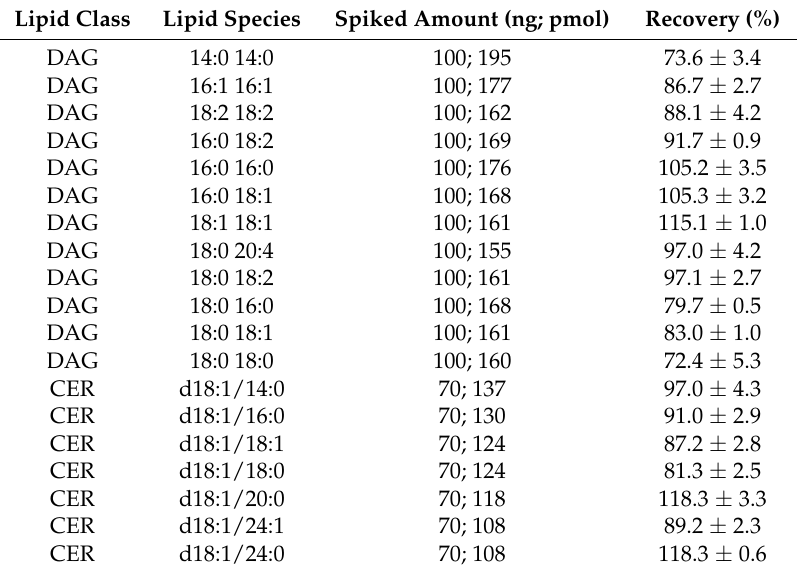
Homogenate of human muscle sample was aliquoted and standard mixture containing 100 ng of each DAG species and 70 ng of each CER species was added before (n = 3) or after extraction procedure (n = 3). The recovery